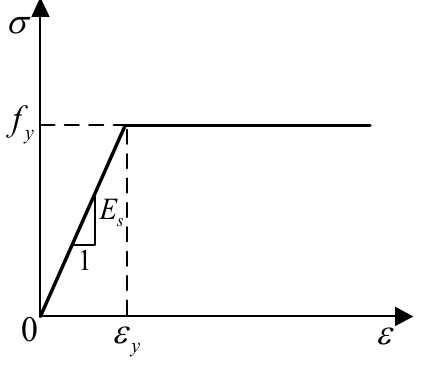
Figure 5. Stress–strain curves of steel.